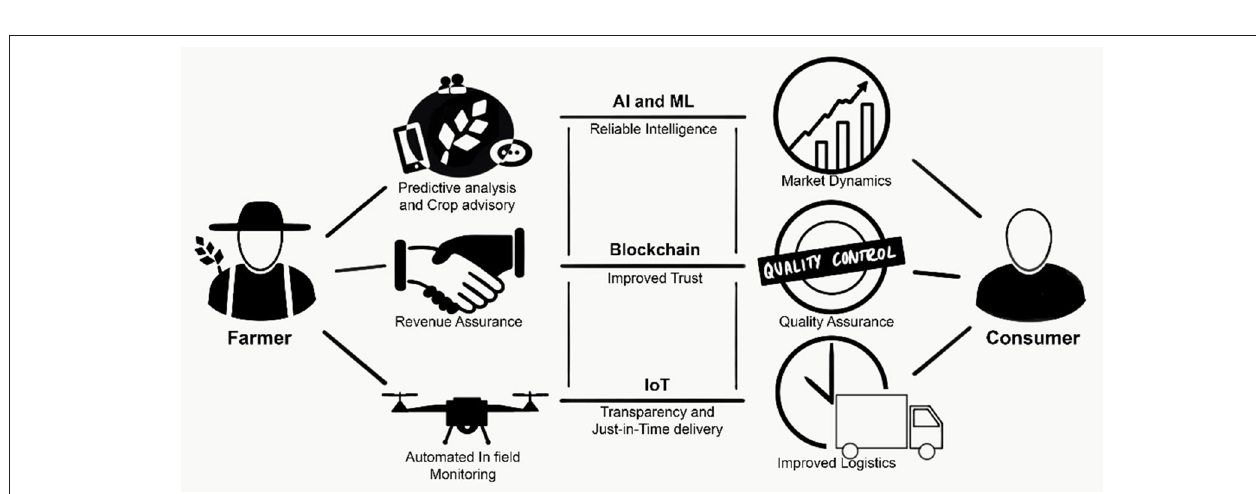
FIGURE 6 | Digitalization in the food supply chain: intelligent precision farming with artificial intelligence (AI) and blockchain. IoT, Internet of Things; ML, Machine Learning. Modified from Salah et al. (2019) and reproduced with permission from IEEE.